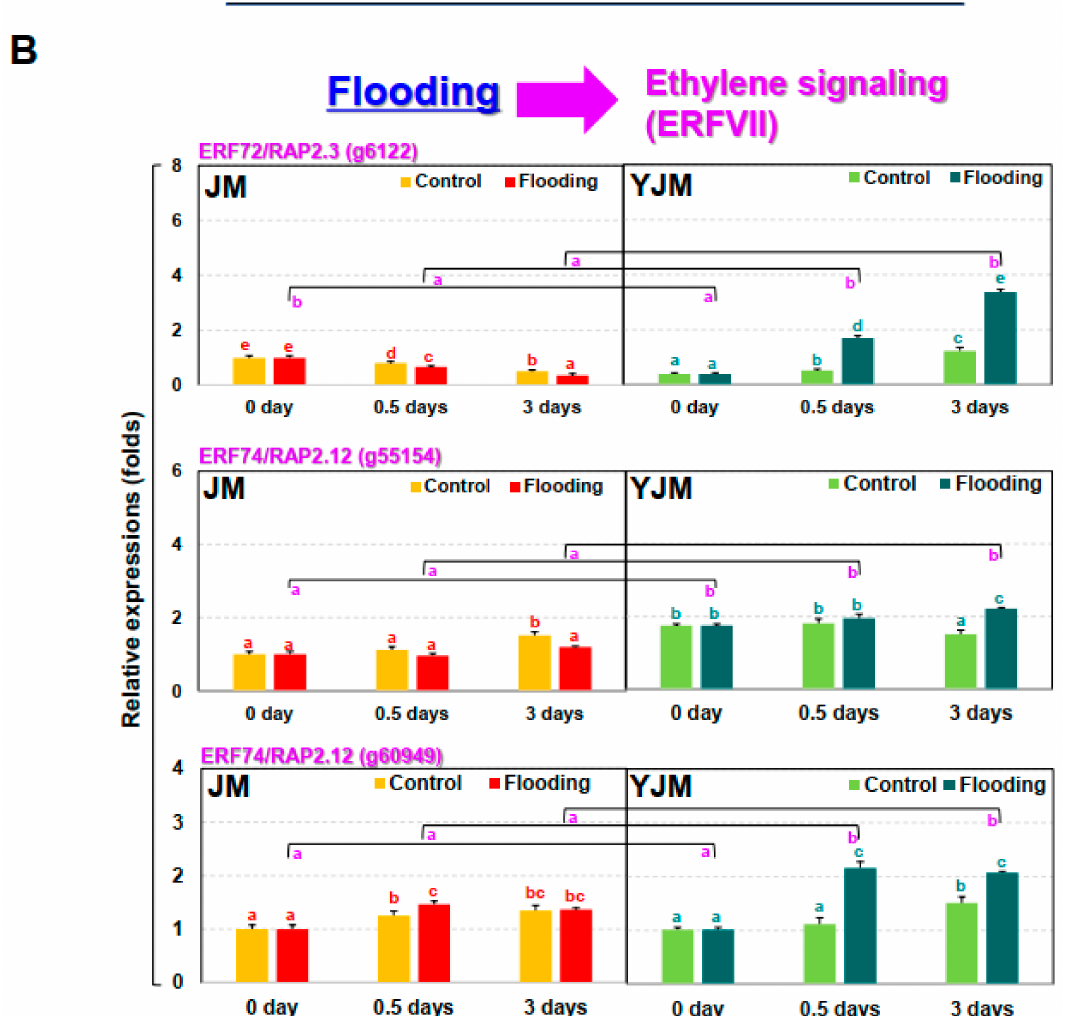
Figure 1. Effects of flooding stress on the sweet potato cultivars Yeonjami (YJM) and Jeonmi (JM). ( A ) Phenotypes of aboveground portions of YJM and JM after 3 d of flooding treatment. ( B ) Expression of ERFVII transcription factors in each cultivar after 0, 0.5, or 3 d of flooding treatment. Different letters represent statistically significant differences between control and flooding treatment, and between flooding-treated JM and YJM, determined using two-way ANOVA with the LSD post hoc test; p <